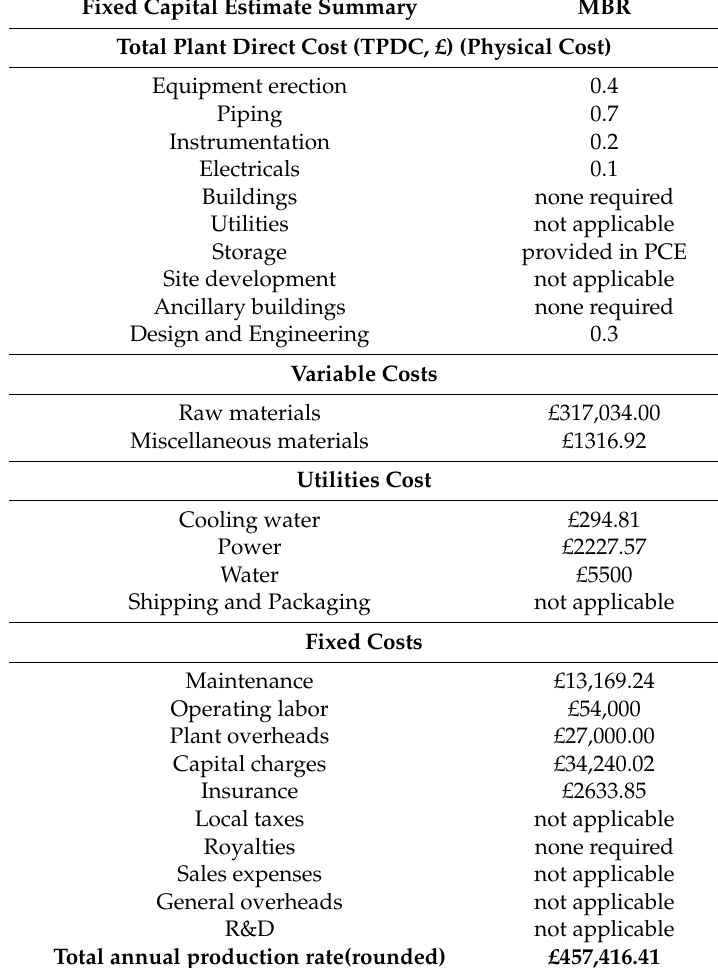
Table 4. Total Plant Direct Cost (TPDC, £) (Physical Cost) (based on 2018 prices) of production of carboxylic acids using the MBR system